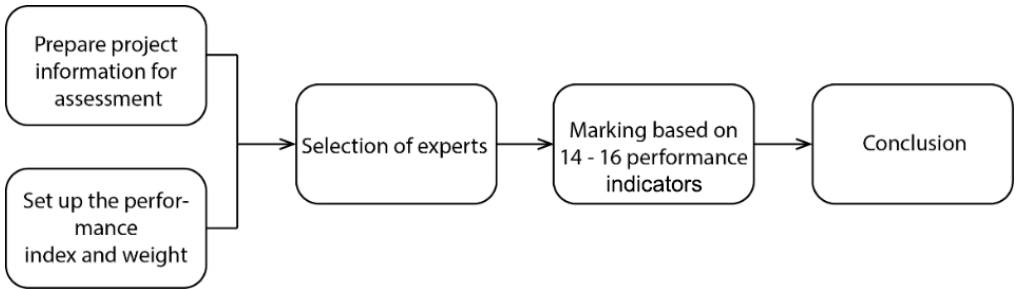
Figure 5. The qualitative assessment workflow in China [30].